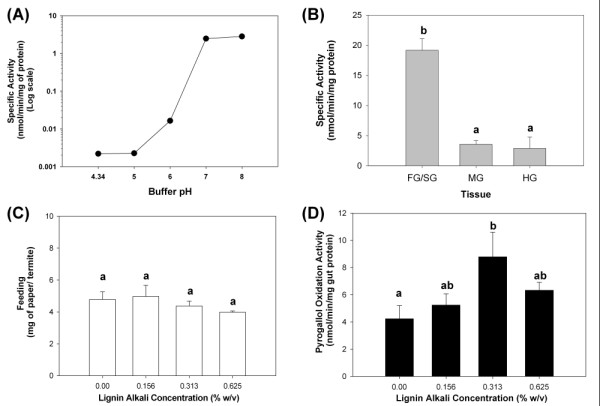
Functional analysis of phenoloxidase activity towards the model substrate pyrogallol. (a) pH dependence of pyrogallol oxidation determined using whole guts of worker termites. (b) Distribution of pyrogallol oxidation activity across the termite gut using 14,000 g supernatants from homogenized tissues of the foregut plus salivary gland (FG), midgut (MG), and hindgut (HG). (c) Feeding by live termites for 7 days on papers treated with lignin alkali at concentrations ranging from 0% to 0.625% w/v. (d) Pyrogallol oxidation activity in whole termite guts after feeding on various concentrations as depicted in (c). Bars with the same letters are not significantly different by least significant difference (LSD) t tests (P < 0.05).